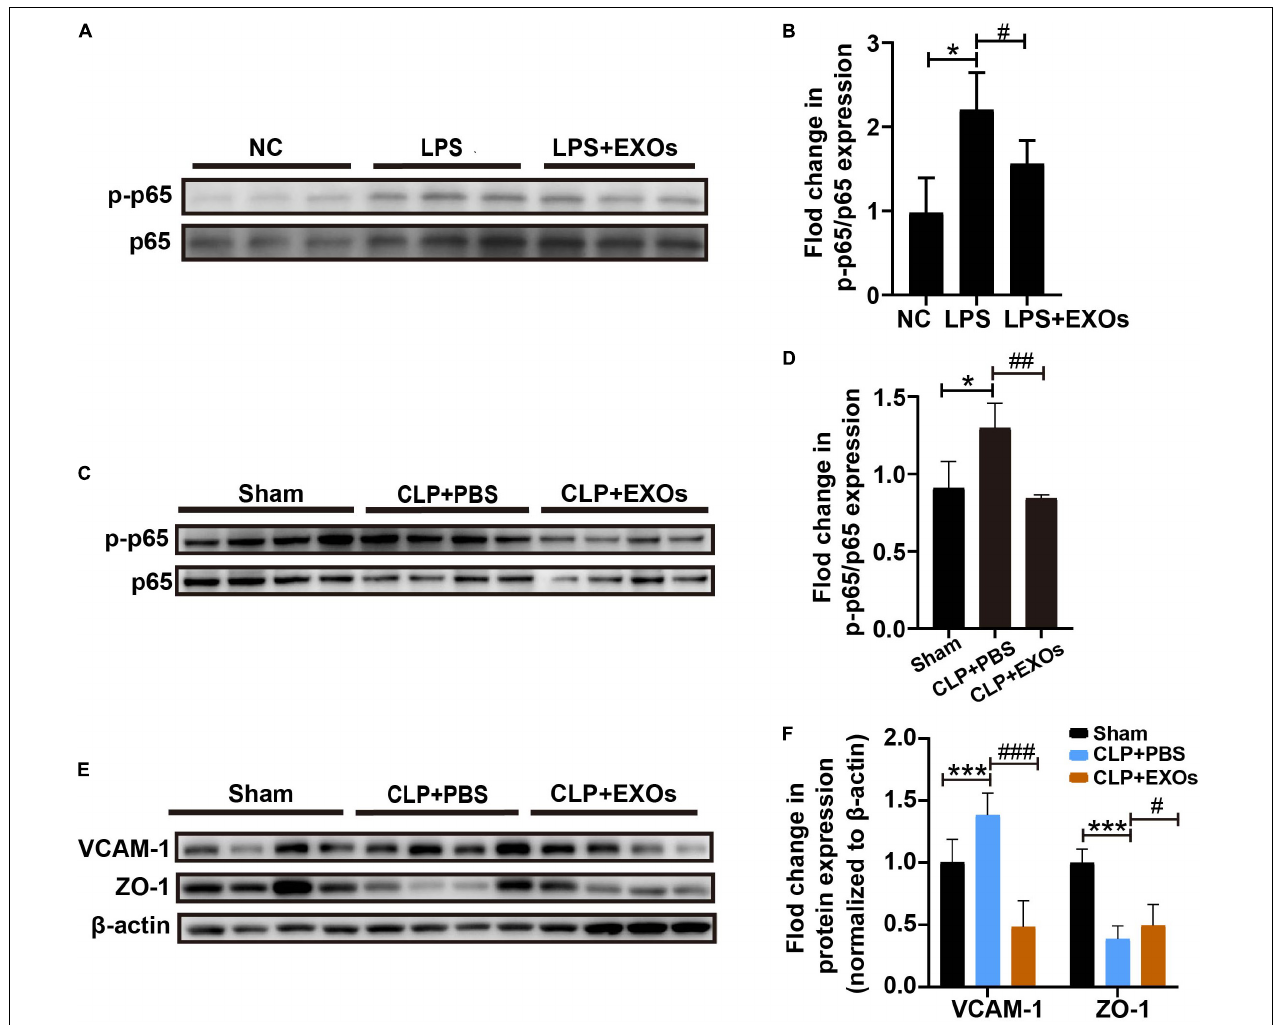
FIGURE 7 | EXOs suppressed nuclear factor kappa B (NF- κ B) pathway activation. (A) Western blot of phosphor-p65 (p-p65) protein level in cultured HUVECs treated with LPS or LPS plus EXOs. (B) Semiquantification of Western blot from HUVECs ( n = 3). * P < 0.05 vs. the NC group; # P < 0.05 vs. the LPS group. (C) p-p65 and p65 expression in mice kidneys 16 h after CLP with PBS or EXOs injection. (D) Semiquantification of Western blots from kidney samples ( n = 4). * P < 0.05 vs. the sham group; ## P < 0.01 vs. the CLP + PBS group. (E) VCAM-1 and zonula occludens-1 (ZO-1) expression in mice kidneys 16 h after CLP with PBS or EXOs injection. (F) Semiquantification of Western blots from kidney samples ( n = 4). *** P < 0.01 vs. the sham group; # P < 0.05, ### P < 0.001 vs. the CLP + PBS